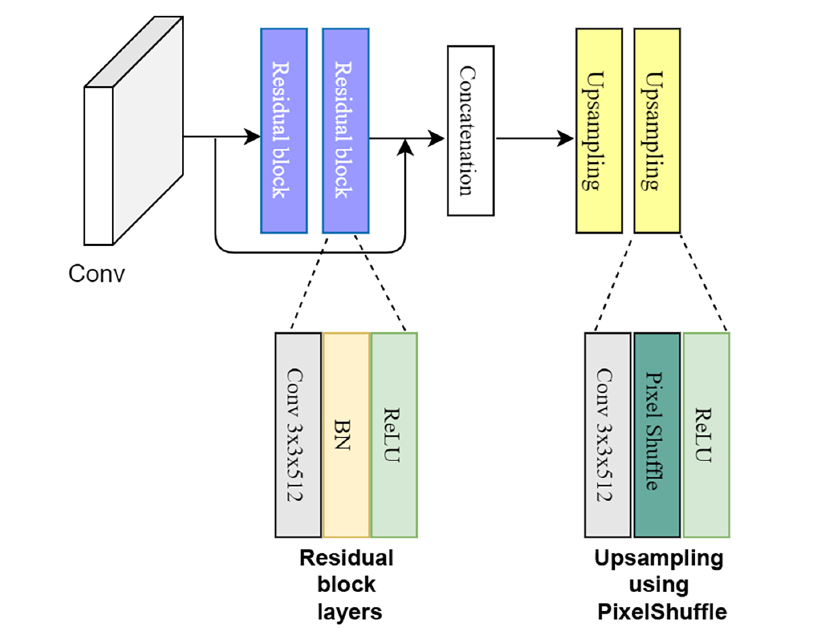
Figure 7. The super-resolution